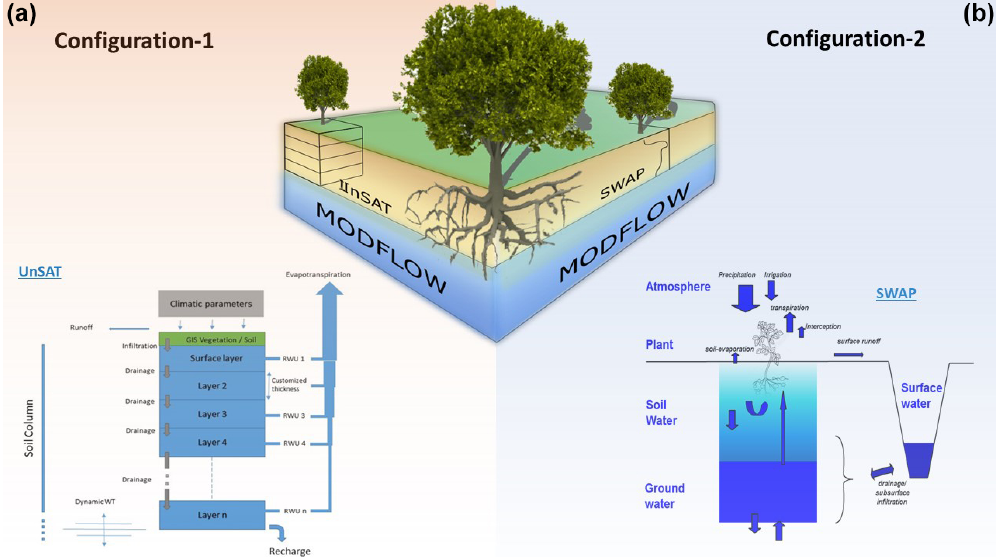
Figure 2. Coupled models’ representation. (a) UnSAT conceptualisation coupled to MODFLOW. (b) SWAP conceptualisation coupled to